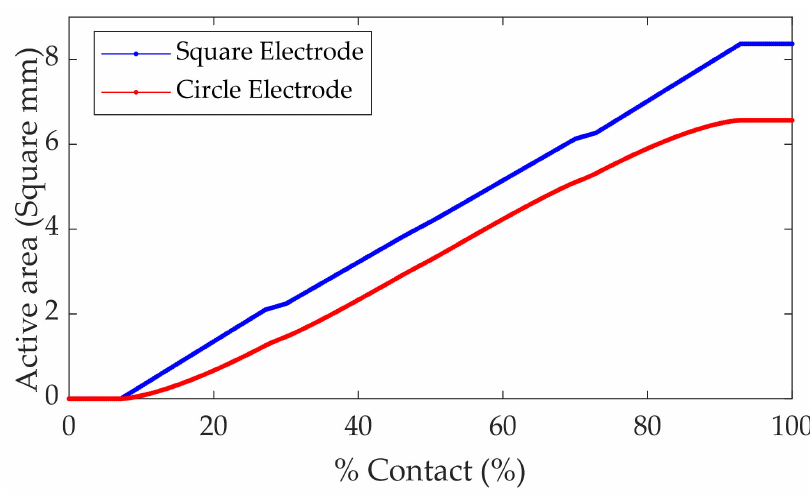
Figure 5. Comparison of the active area per % contact of the